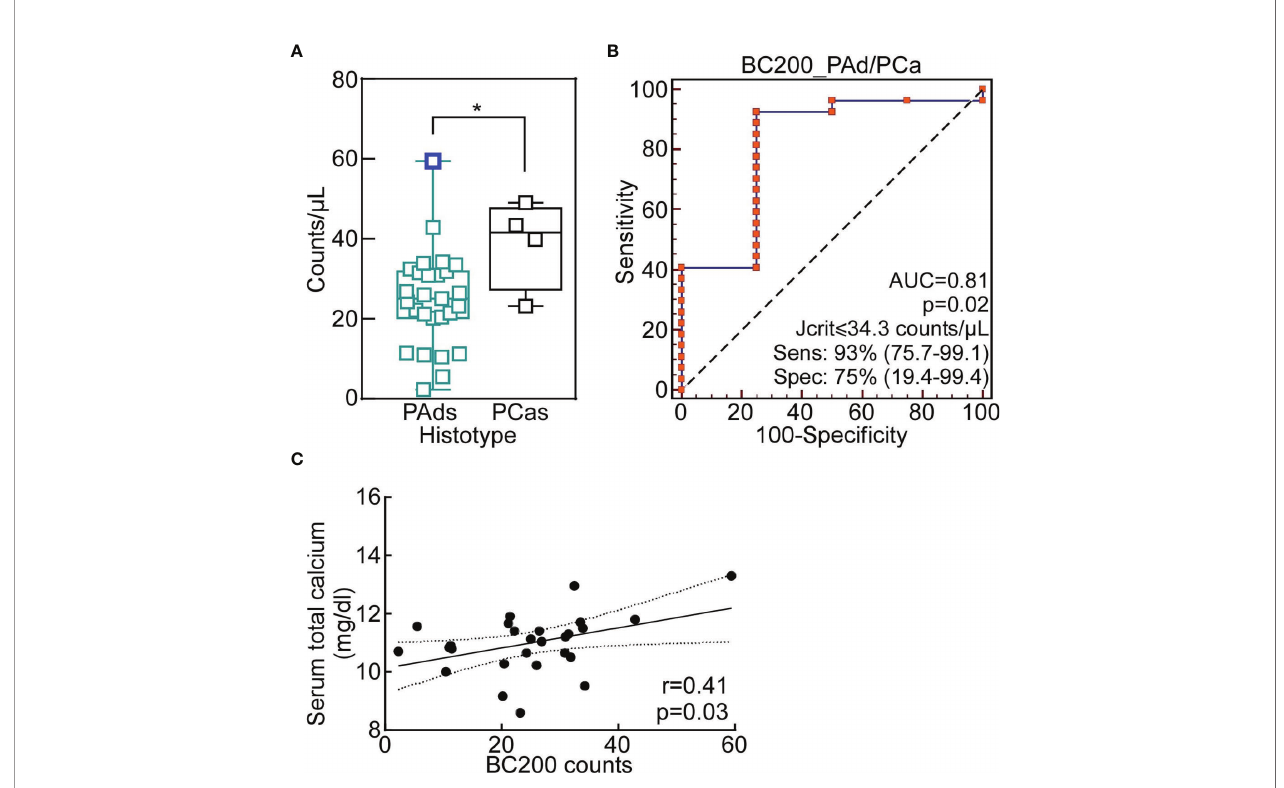
FIGURE 1 | Circulating BC200 expression discriminates between parathyroid adenomas and carcinomas. (A) BC200 expression levels in PAds and PCas serum. Each sample is a square and data are presented as box-plot with median. Whiskers represent min to max values. *, p=0.04 from Mann-Whitney U-test. The blue square indicates the PAd7. (B) The ROC analysis with the Youden criterion was used to identify the optimal cut-off to differentiate PAds from PCas. P=0.02; Youden associated criteria ≤ 34.3 counts/µl. (C) Pearson correlation analysis was performed for PAds between BC200 serum levels and serum total calcium (p=0.03). The Pearson correlation coef fi cient, r value, is indicated in the graph. AUC, Area Under the ROC Curve; ROC, Receiver-Operating